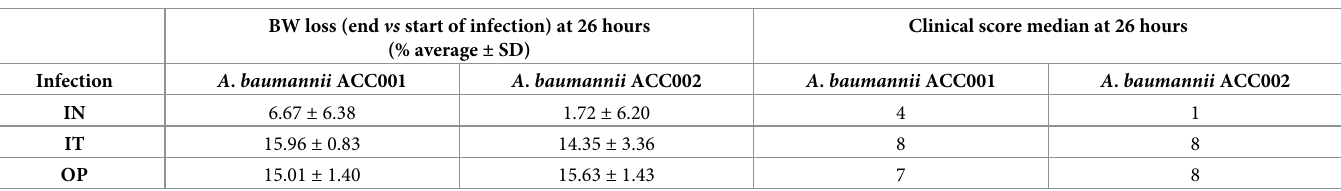
Table 4. Body weight and clinical score.